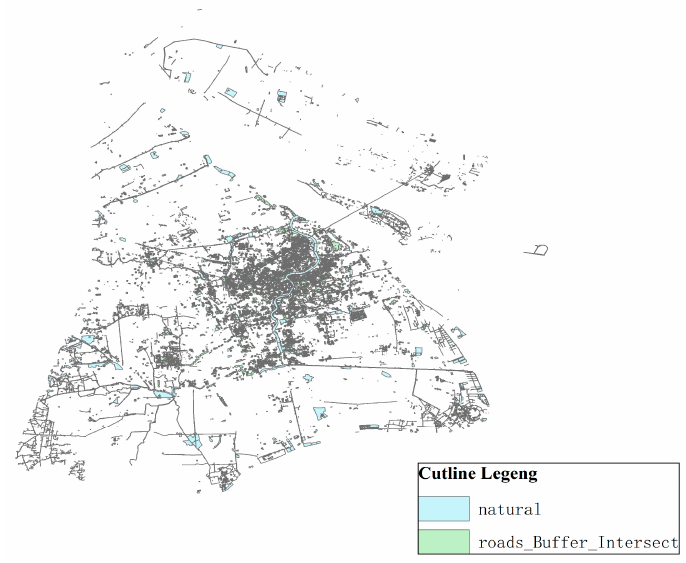
Figure 10. Image overlay analysis.